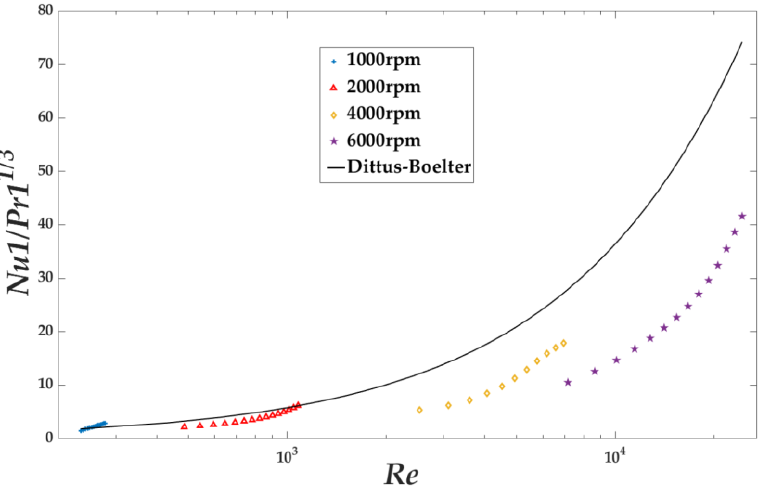
Figure 13. Experimental and reference Nusselt number at different Reynolds number and speed. The correction factor α was determined through the Taylor flow heat transfer experiment. It is 1.155 at 1000 rpm, 0.789 at 2000 rpm, 0.546 at 4000 rpm, and 0.457 at 6000 rpm, shown in Table 2. Table 2. Deviation of experimental Nusselt number to the Dittus – Boelter relation and correction factor α at different speed.